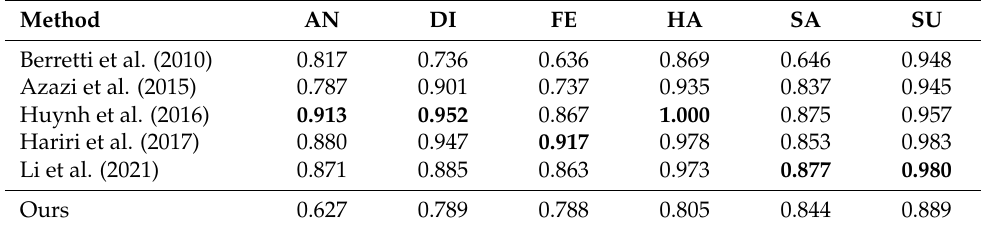
Figure 7. Loss and accuracy on the 3D-BUFE dataset. Table 5. Comparison of classification accuracy with other methods on the 3D-BUFE dataset, the best results in each expression are emphasized with